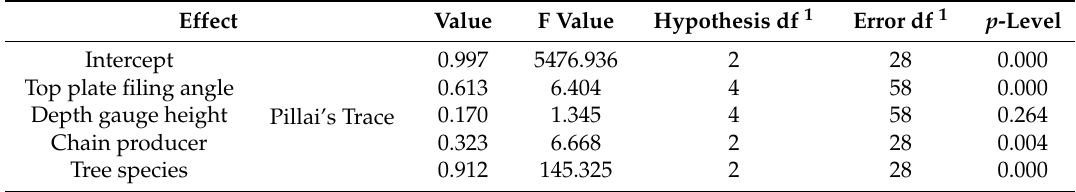
Table 3. MANOVA results between particle size distribution and independent factors.